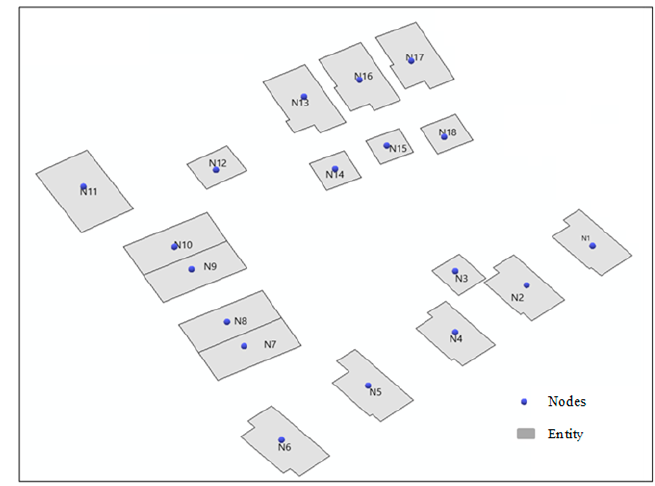
Figure 1. Numbering spatial polygons.